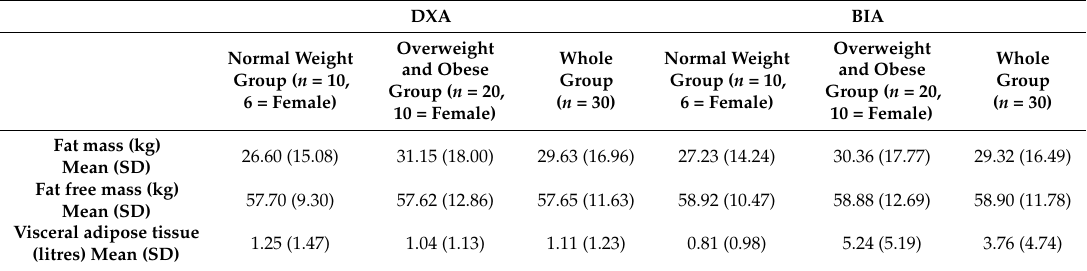
Table 2. Fat mass, fat-free mass, and visceral adipose tissue volume, as measured by DXA and